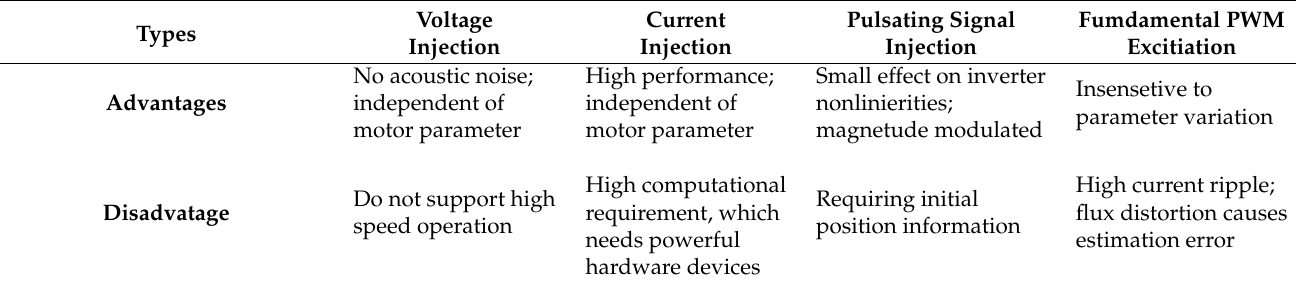
Table 3. Comparison of saliency-based methods.